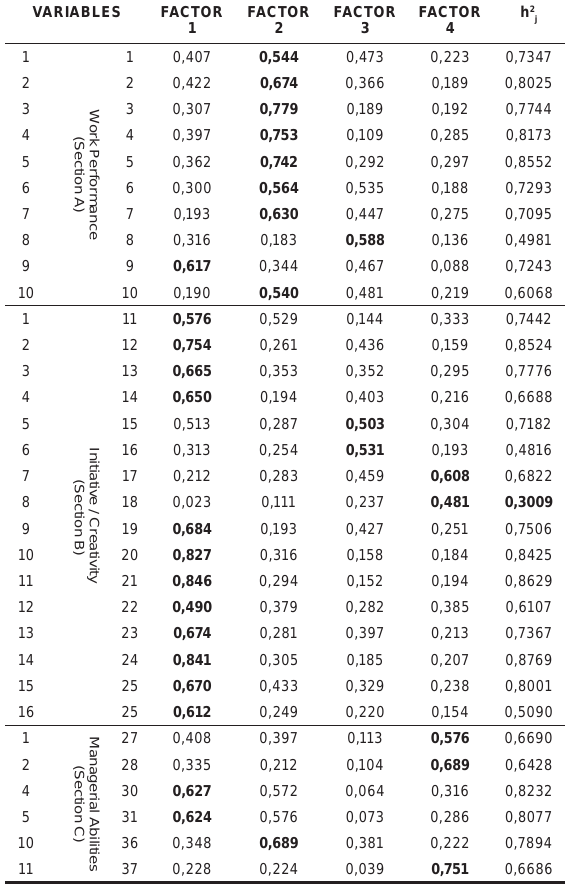
TAbLE 11 rotation)